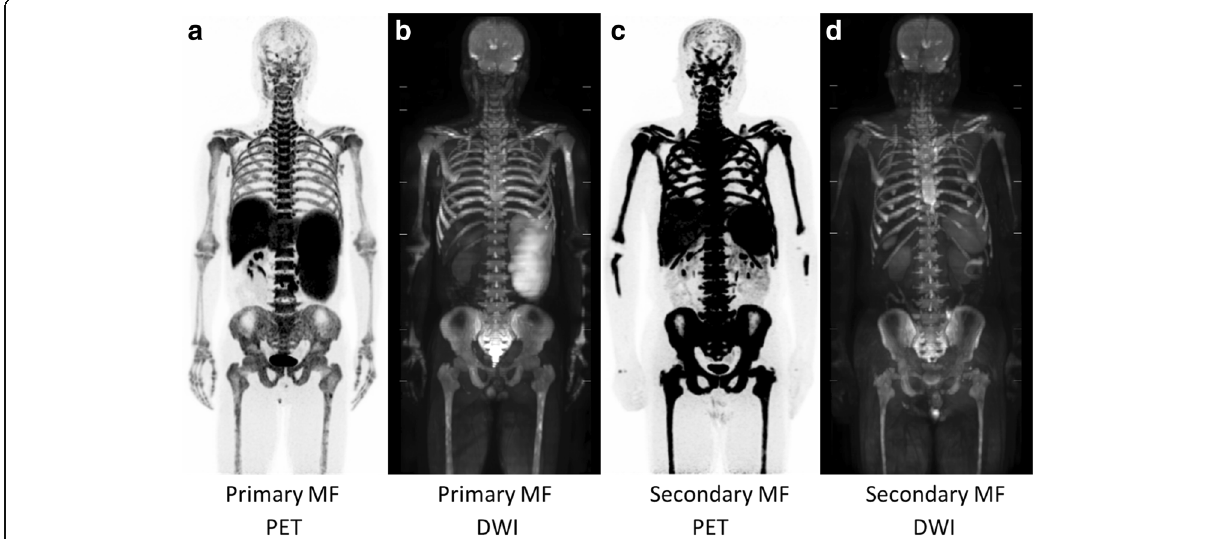
Fig. 8 Maximum intensity projection 18 F-FLT PET ( a , c ) and DWI ( b , d ) images of MF patients. A primary MF patient exhibited normal or slightly decreased bone marrow activity in the central skeleton, but they had marked expansion to the distal extremities and high uptake of the tracer in the enlarged spleen ( a ). On the other hand, a secondary (post-ET) MF patient had marked 18 F-FLT uptake in bone marrow ( c ). Whole-body DWI displayed homogenously high signal intensities in bone marrow of primary and secondary MF patients ( b , d ,